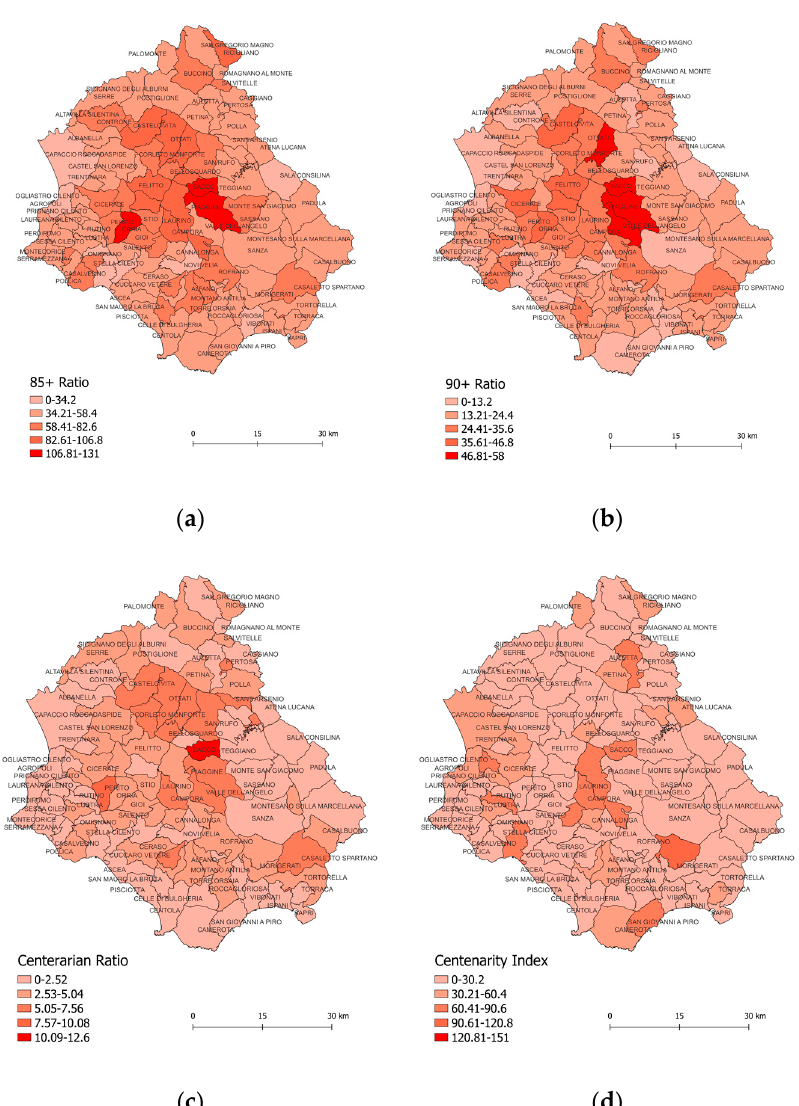
Figure 1. Spatial distribution of the four longevity indices in Cilento municipalities. Note: ( a ) Spatial distribution of 85+ ratio; ( b ) Spatial distribution of 90+ ratio; ( c ) Spatial distribution of centenarian ratio; ( d ) Spatial distribution of centenarity